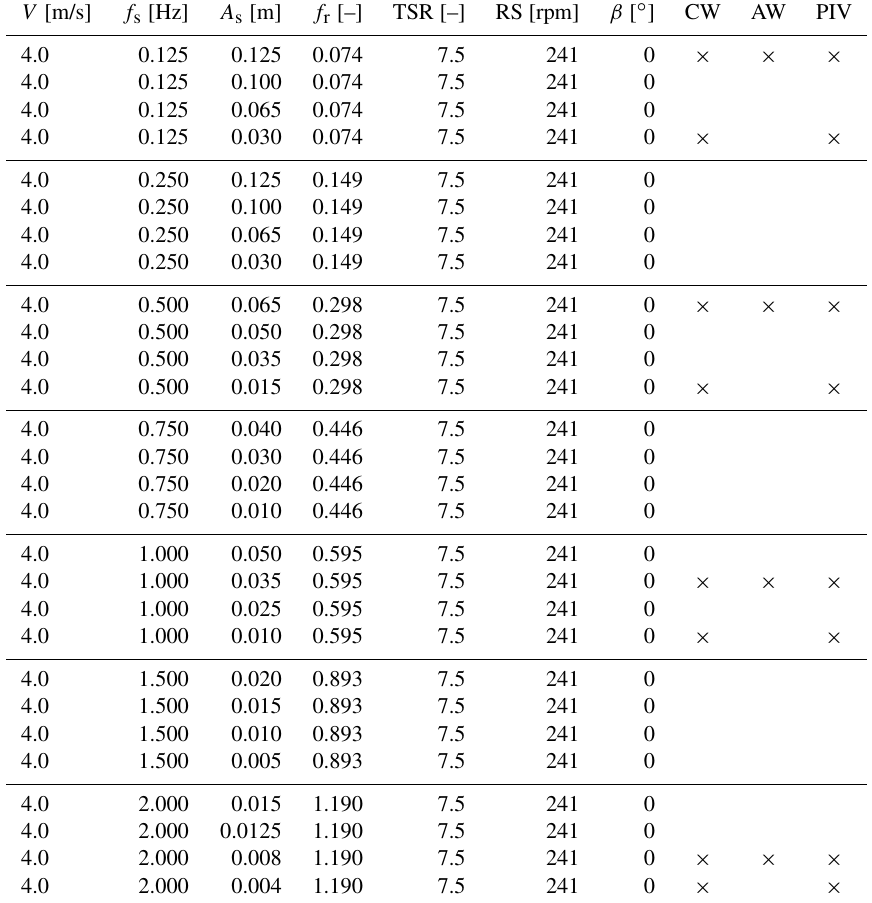
Table B2. RATED2 test matrix. V is the mean wind speed, f s the surge frequency, A s the surge amplitude, f r the reduced frequency, TSR tip-speed ratio, RS the rotor speed, and β the blade pitch angle. The CW, AW, and PIV columns indicate whether a cross-wind, along-wind, or PIV measurement of the wake was carried